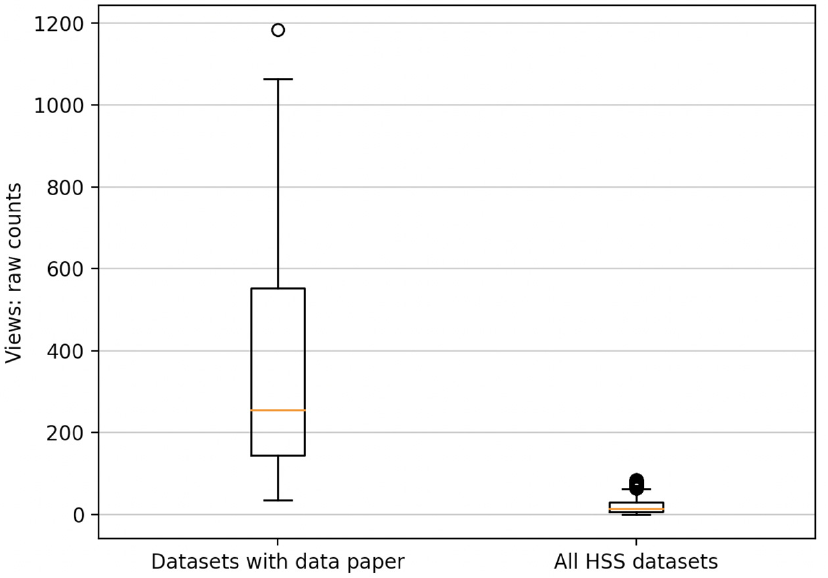
Figure 14. Comparison between datasets with an associated data paper and all HSS datasets (2015– 2022): views. Table 9. Welch’s t -test and Mann–Whitney U -test results: mean views of datasets with an associated data paper and all HSS datasets between 2015 and 2022, at each random sampling of the latter.